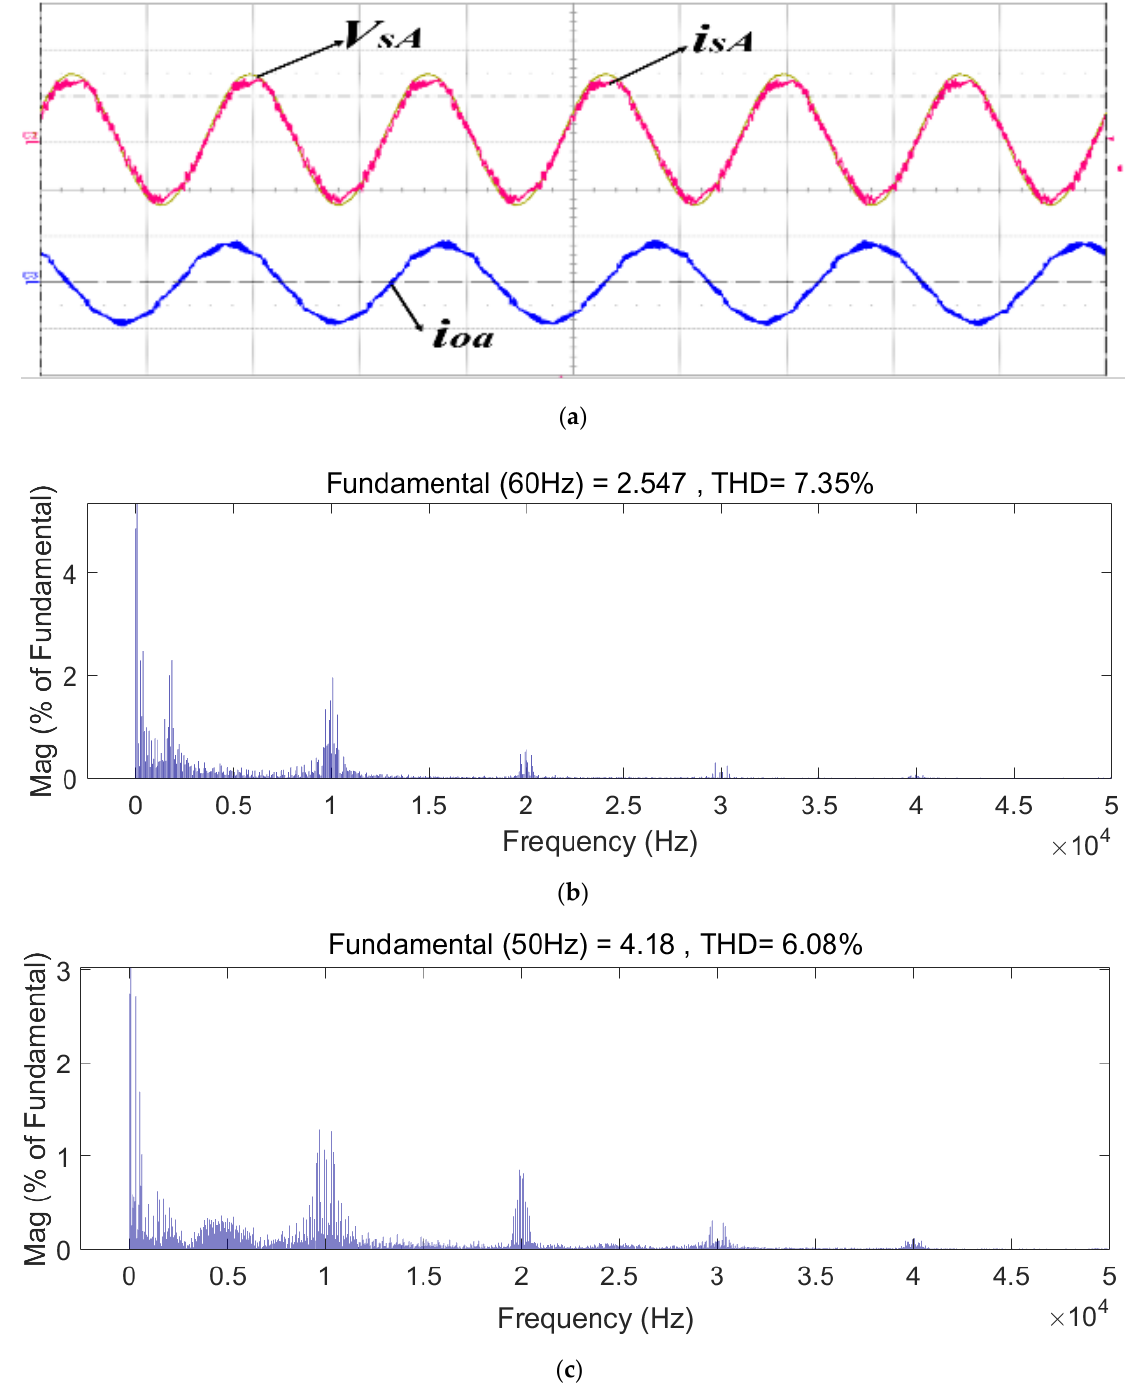
Figure 14. Experimental results of the proposed VMMPC strategy with the IFRS for the TSMC, where output-current reference amplitude is set to 4.3 A and output-current frequency is set to 50 Hz, x-axis 10 ms/div ( a ) Waveforms of the source voltage 𝑉 𝑠𝐴 (100 V/div), source current 𝑖 𝑠𝐴 (2 A/div) and output current 𝑖 𝑜𝑎 (5 A/div). ( b ) Spectrum distribution of 𝑖 𝑠𝐴 . ( c ) Spectrum distribution of 𝑖 𝑜𝑎 .